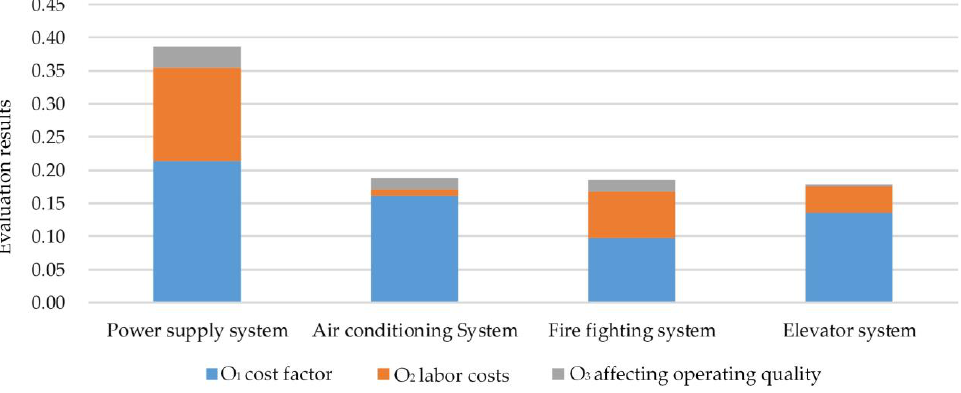
Processes 2023 , 11 , 100 Figure 6. The weights of evaluation factors in the 2nd layer of the power supply, air conditioning, firefighting, and elevator systems.